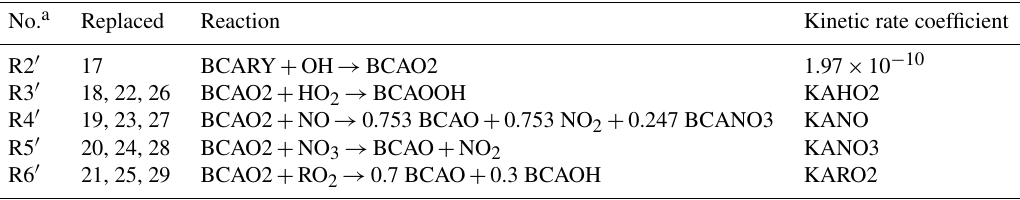
a The symbol (cid:48) is used to distinguish the reactions in this table from the corresponding number of lumping reactions in Table